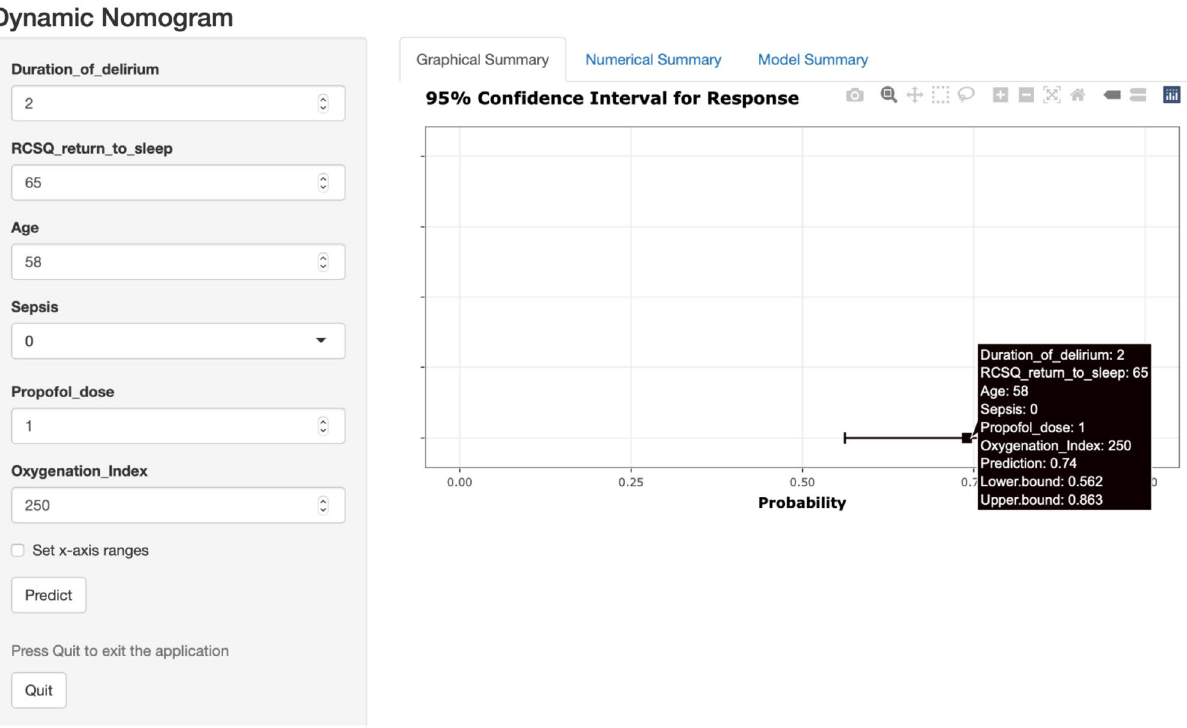
Figure 7. Web-based risk calculator of PICS-CI (Example of a 58-year-old critically ill patient complicated with delirium for 2 days and having fair sleep quality (RCSQ-returning to sleep = 65), no sepsis, use propofol, and PO 2 /FiO 2 value of 250 in daily assessment; this patient would have a 74% risk of